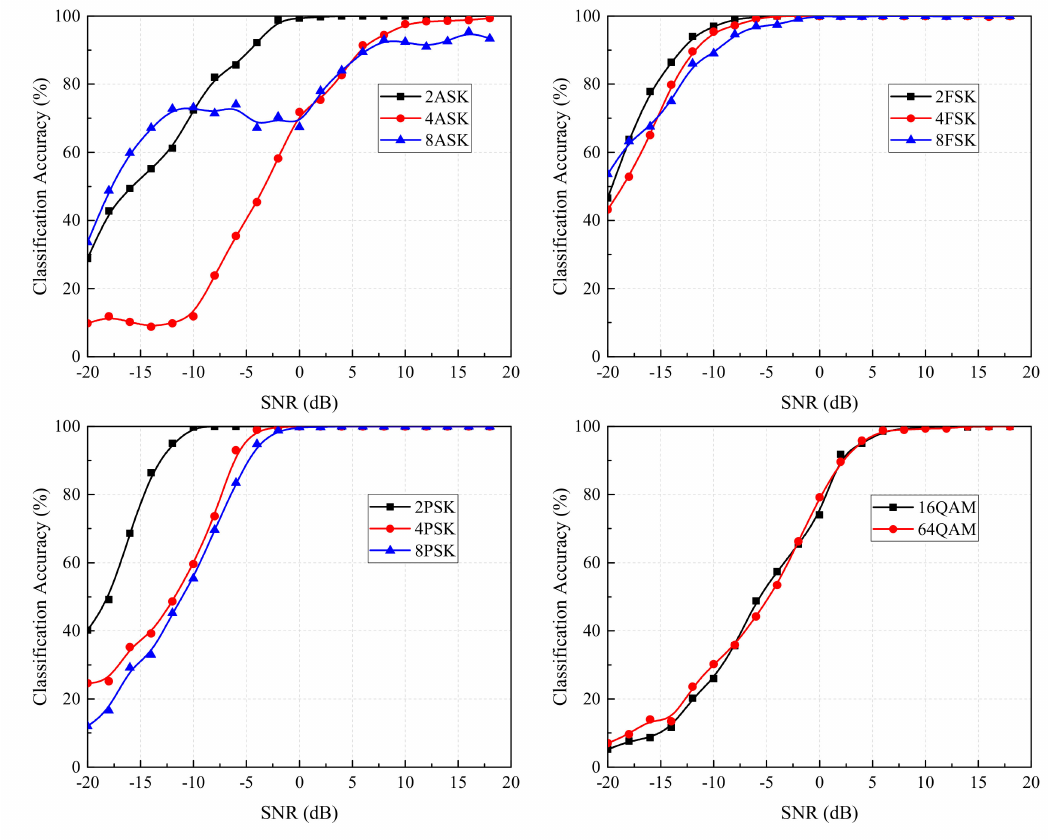
Figure 8. Curves about intra-class classification accuracy versus